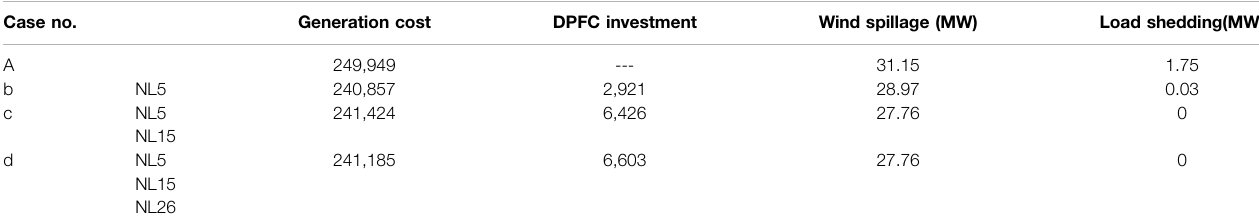
TABLE 3 | Optimal dispatch performance with the optimal DPFC under the worst-case scenario. Case